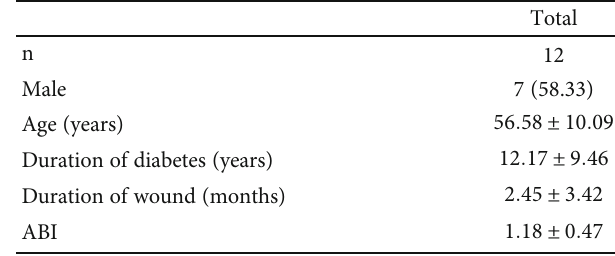
Table 1: Baseline characteristics of